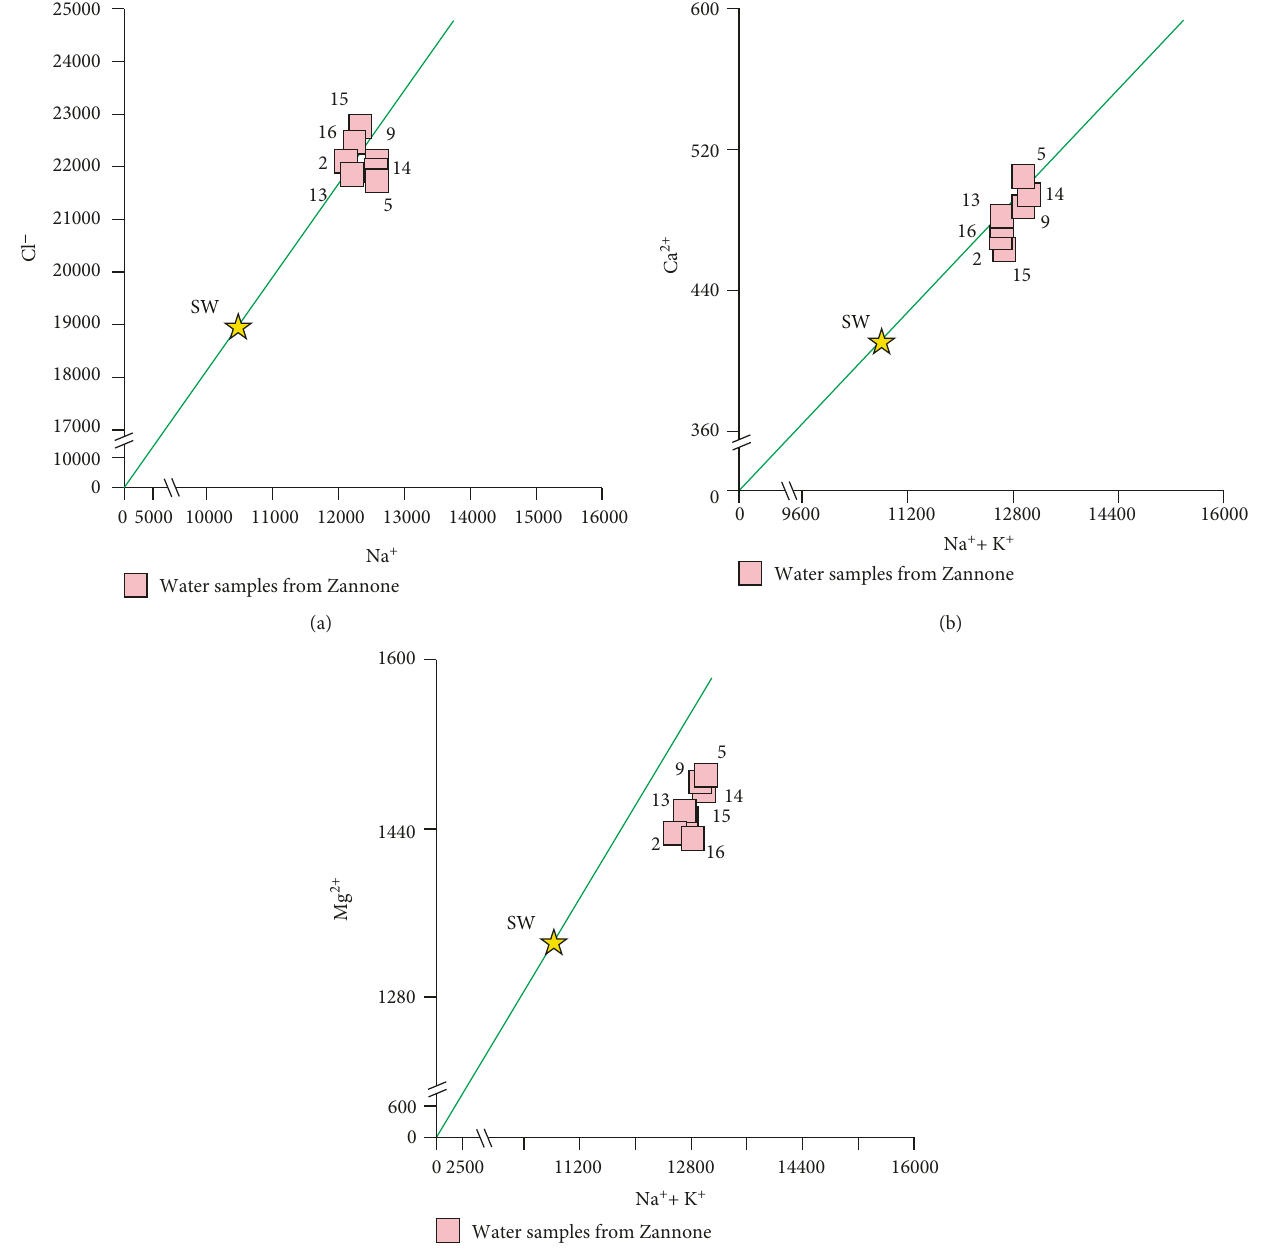
Figure 4: Geochemical features of water samples from Zannone. The star indicates the local seawater. (a) Na vs. Cl (mg/l) binary diagram; (b, c) Ca and Mg vs. Na+K concentrations